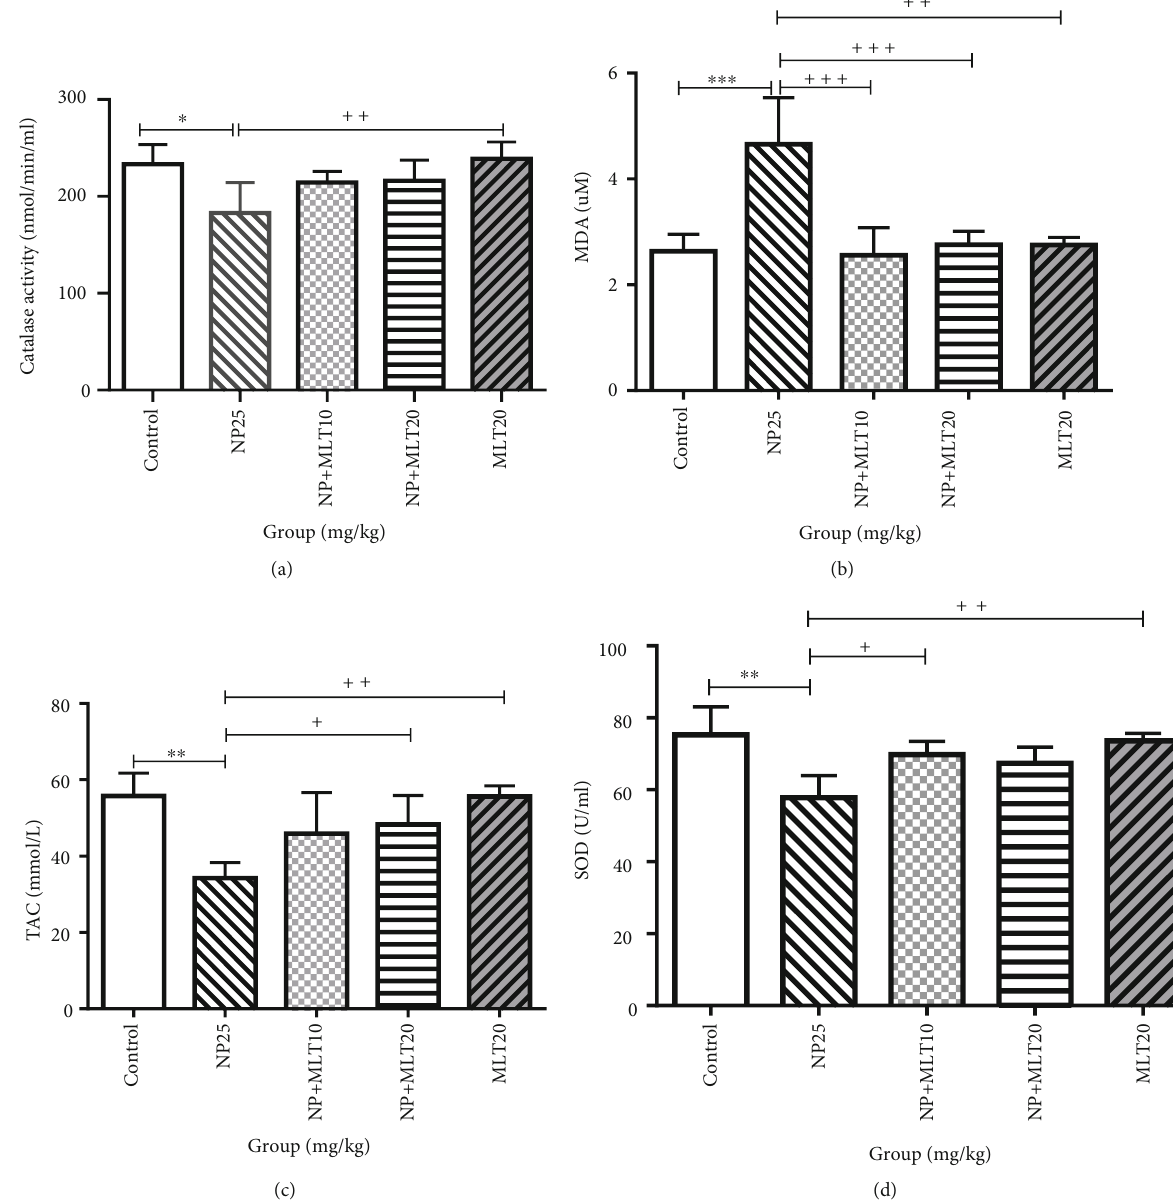
Figure 2: MLT balanced oxidative and antioxidant mediators in NP-treated rats. Comparison of (a) catalase activity, ∗ signi fi cant di ff erence from the control group at p < 0 : 05 ; ++ signi fi cant di ff erence from the NP group ( p < 0 : 001 ). (b) MDA activity, ∗∗∗ signi fi cant di ff erence from the control group at p < 0 : 001 , ++ signi fi cant di ff erence from the NP group ( p < 0 : 001 ), and +++ signi fi cant di ff erence from the NP group ( p < 0 : 0001 ). (c) Total antioxidant capacity (TAC) activity, ∗∗ signi fi cant di ff erence vs. the control group at p < 0 : 001 , + signi fi cant di ff erence from the NP group ( p < 0 : 05 ), and ++ signi fi cant di ff erence from the NP group ( p < 0 : 001 ). (d) SOD activity, ∗∗ signi fi cant di ff erence vs. the control group at p < 0 : 001 , + signi fi cant di ff erence from the NP group ( p < 0 : 05 ), ++ signi fi cant di ff erence from the NP group ( p < 0 : 001 ). Bars represent mean ± SD ( n = 4 ). NP: nonylphenol; MLT: